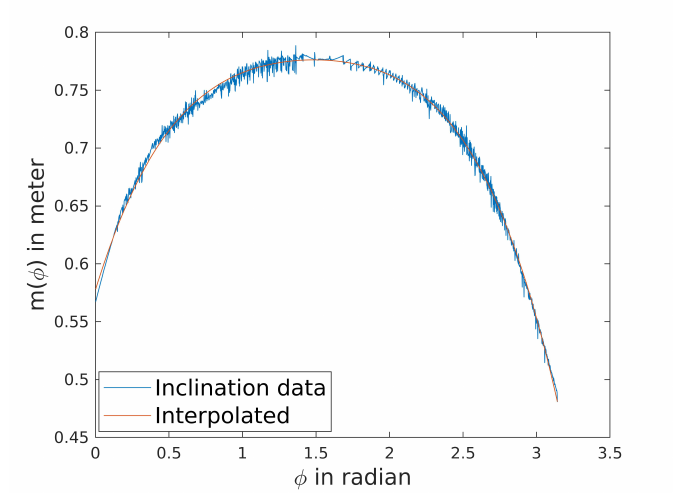
Figure 10. Inclination function of the Sixdays